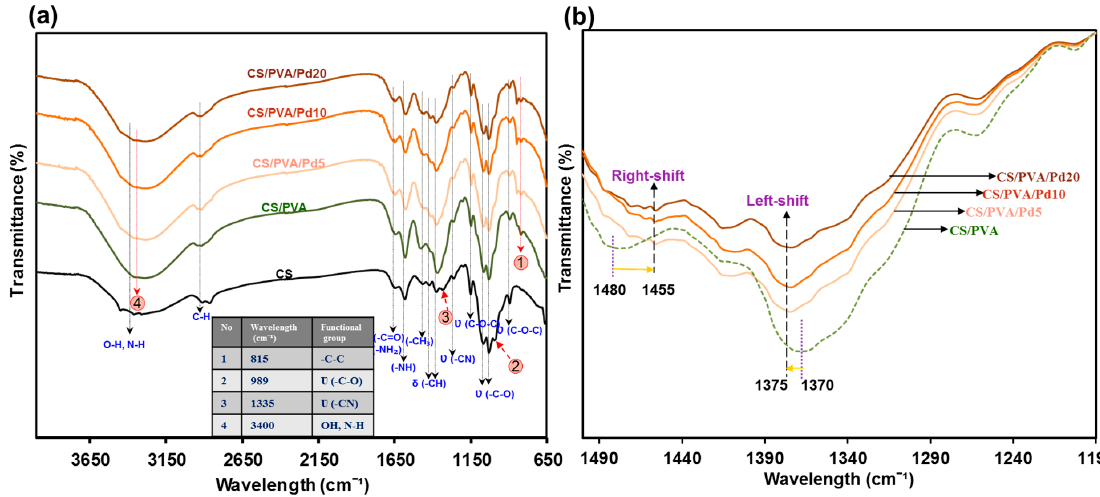
Figure 4. ( a ) Fourier transform infrared spectroscopy (FTIR) of CS/PVA and CS/PVA/PdNPs dressings and ( b ) Shifted peaks on FTIR spectrum of dressings.